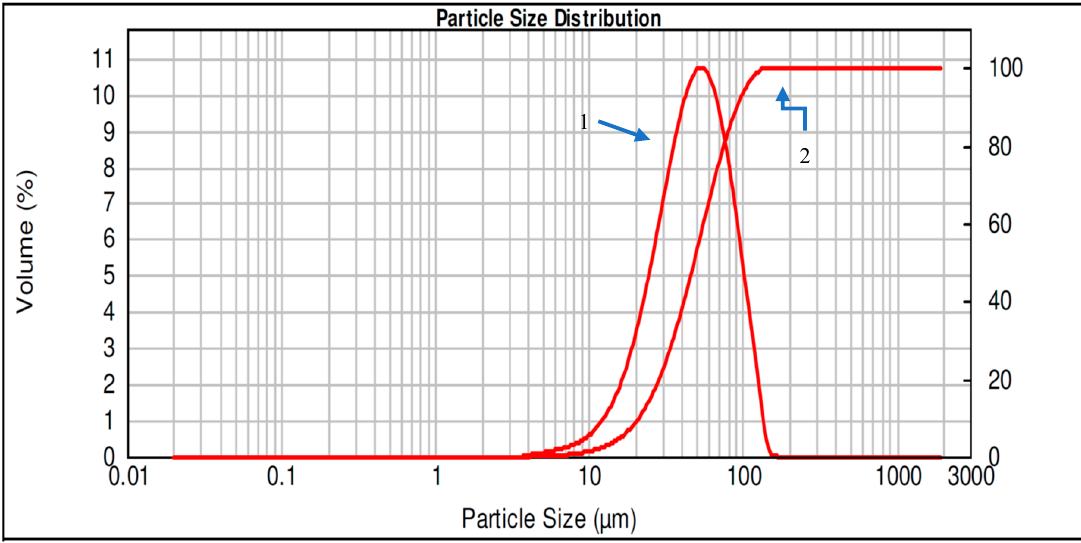
Figure 3. Particle size distributions for the HDH titanium powders. Curve ( 1 ) shows the volume percent at the corresponding particle size, and curve ( 2 ) shows the accumulated volume percent under the corresponding particle size.